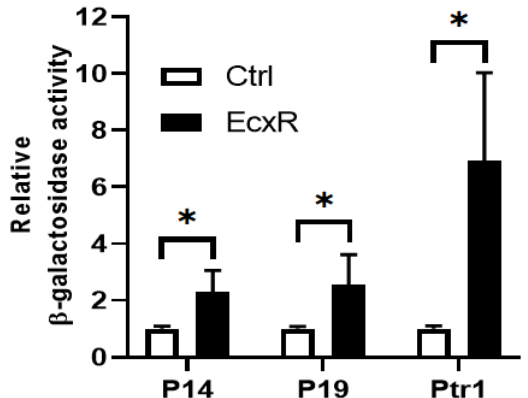
Figure 5. Yeast one-hybrid assay to independently confirm the binding of EcxR to three E. chaffeensis promoters; p28-Omp14 (P14), p28-Omp19 (P19) and tr1 (Ptr1). The β -galactosidase assays were used to quantitate the interaction strength of EcxR binding to three promoters, respectively. Eenzyme activities relaive to the negative control (the empty vector pDEST22) were shown for the three promoters. The values are the means ± standard deviations for three independent biological replicates. Ctrl refers to the negative control (the empty vector pDEST22), while EcxR represents to the expression of AD-EcxR chimeric protein in pDEST22-ecxR. Significant differences from the values for samples lacking the expression of protein EcxR were determined by the t test (* p < 0.05).